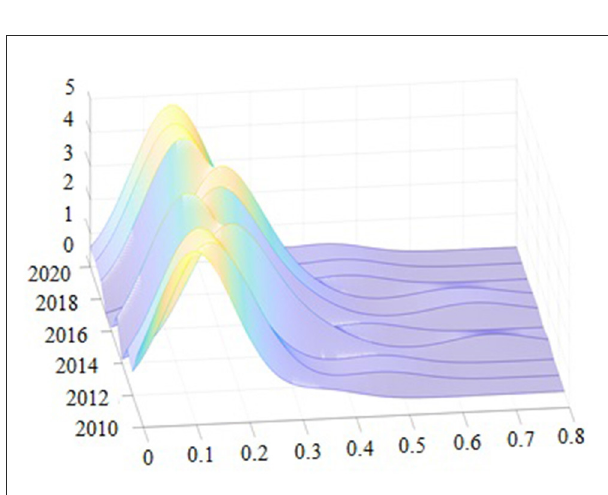
while the types of provinces with low tourism ecosystem health levels were decreasing. From a morphological point of view, the overall kernel density curve did not show a decreasing peak or increasing width. However, the sample period was characterized by multiple peaks, implying a particular gradient of differences in the tourism ecosystem health in